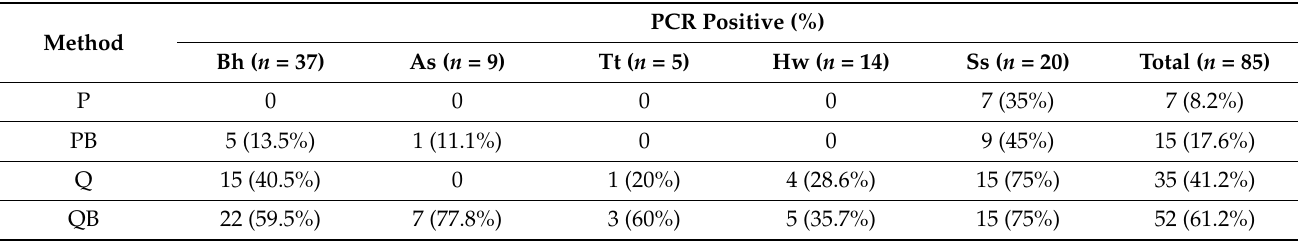
Figure 6. Representative results from PCR for the detection of A. lumbricoides ( A ), S. stercoralis ( B ), N. americanus ( C ), T. trichiura ( D ), and Blastocystis sp. ( E ) using DNA extracted from stool samples from each patient using the phenol-chloroform method (P), the phenol-chloroform method with glass beads (PB), the QIAamp Fast DNA Stool Mini Kit (Q), and the QIAamp Power Fecal Pro DNA Kit (QB). M: DNA marker; Neg: negative control; Pos: positive control. Table 2. Comparison of the PCR positive rate for the detection of intestinal parasites, according to the DNA extraction method. Bh: Blastocystis sp., As: Ascaris lumbricoides , Tt: Trichuris trichiura , Hw: hookworm, Ss: Strongyloides stercoralis .